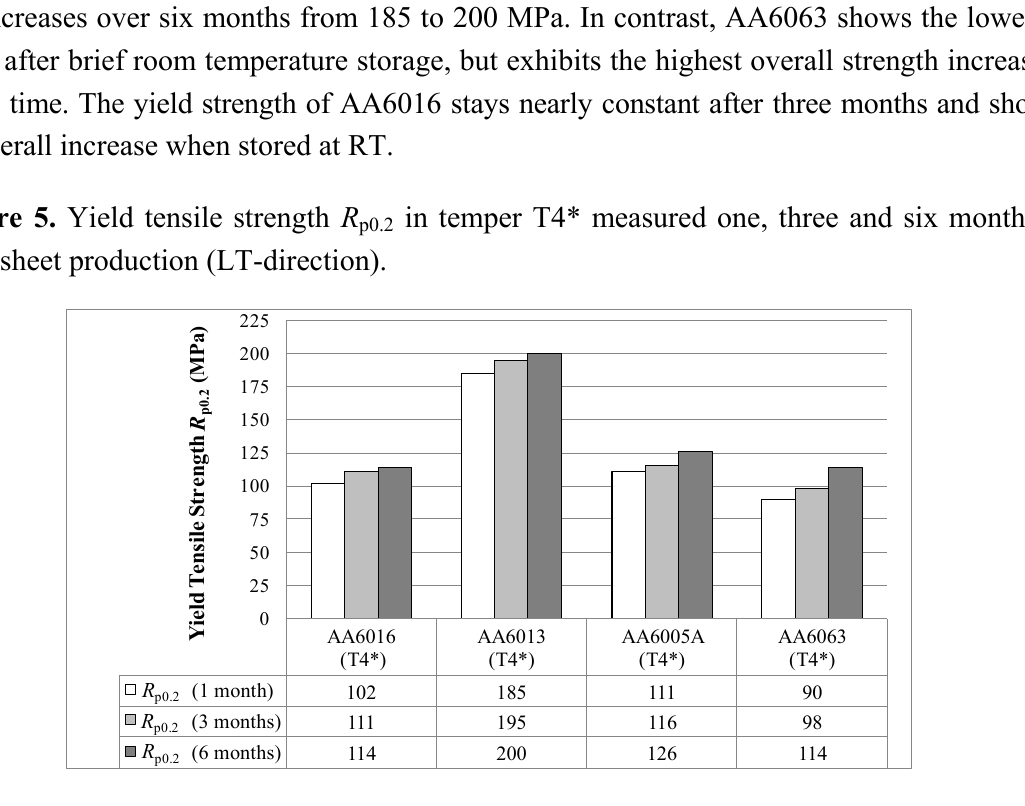
in temper T4* measured one, three and six months p0.2